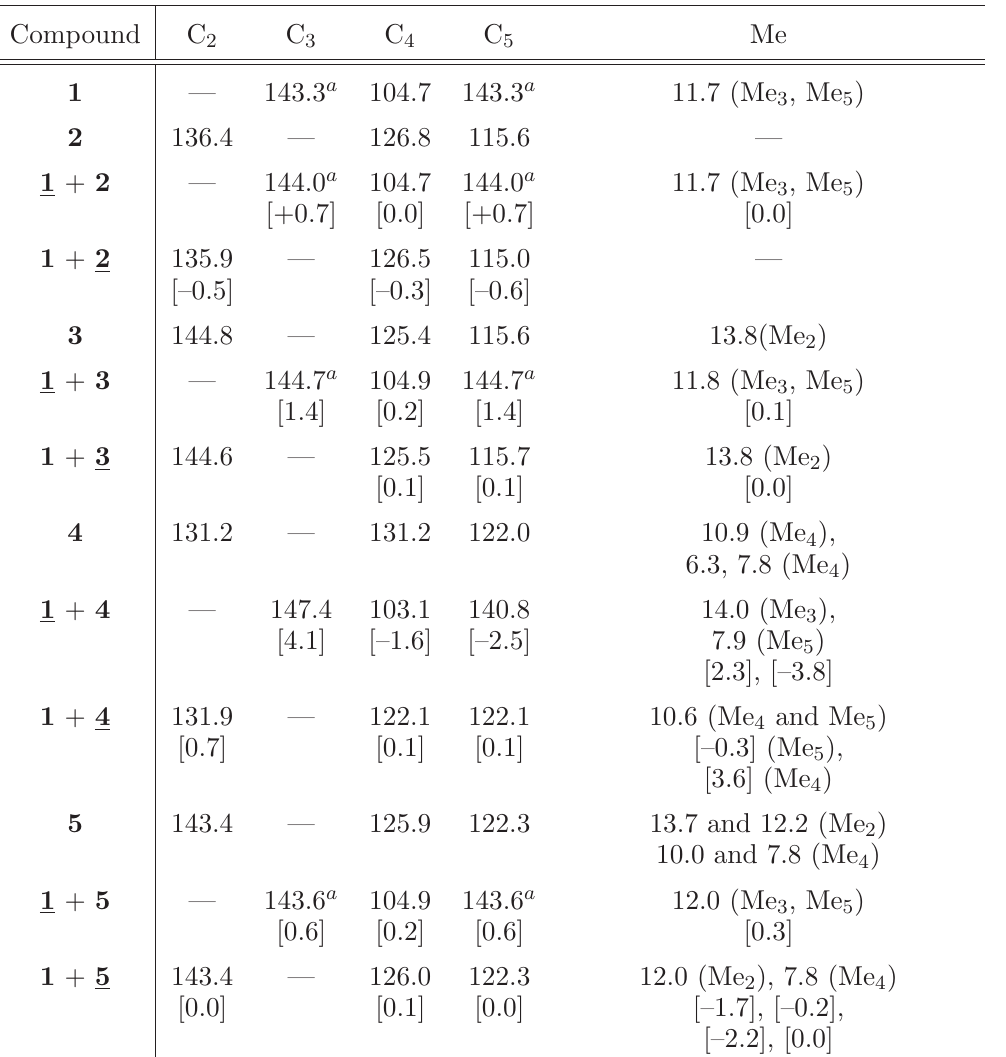
Table 5 13 C CPMAS NMR chemical shifts and ∆ δ = δ mixture – δ azole effects in ppm of the azole